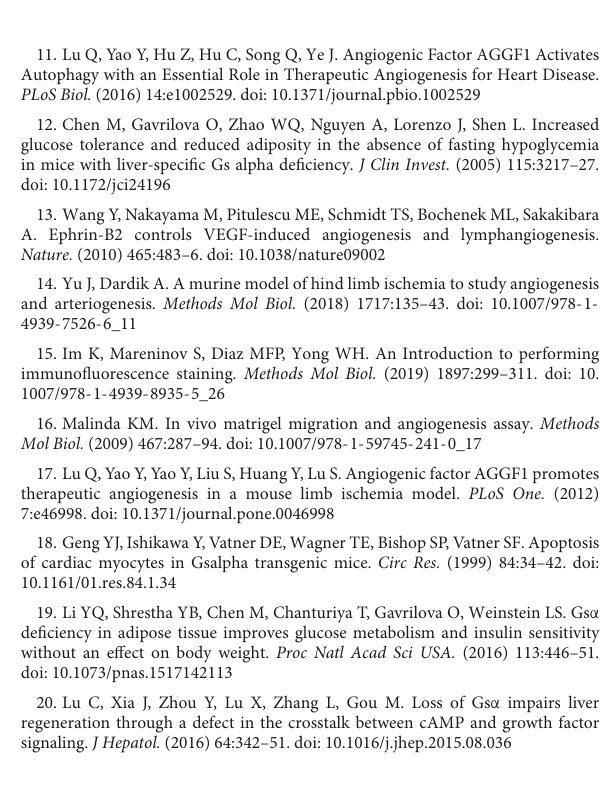
AGGF1 (red) and DAPI in gastrocnemius muscle of mice infected with LacZ or AGGF1 adenovirus. Scale bar, 20 µ m. n = 3, ∗∗ P < 0.01 vs. LacZ (unpaired Student’s t -test). Data are mean ±